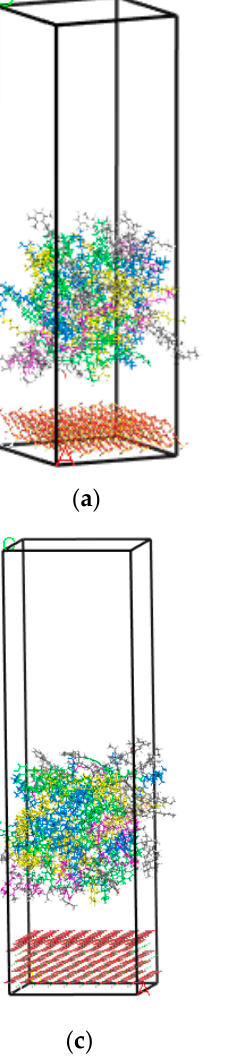
Figure 6. ( a ) Interface model of CR–augite. ( b ) Interface model of CR–water–augite. ( c ) Interface model of CR-calcite. ( d ) Interface model of CR–water–calcite.